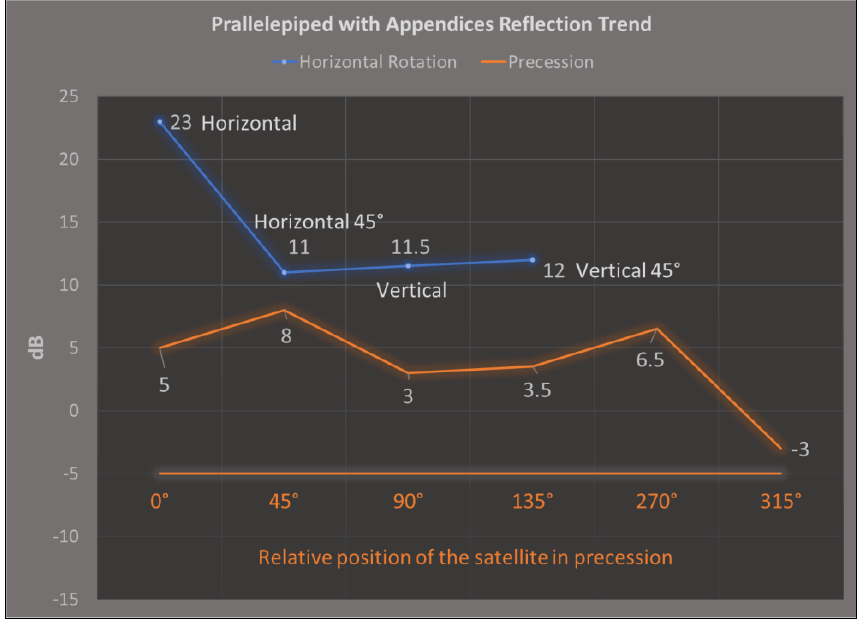
Figure 11. Parallelepiped with appendices reflection trend.